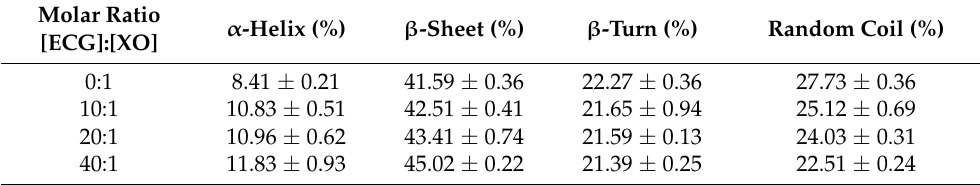
Figure 4. Structural change analysis. ( A ) The CD spectra of XO at different molar ratios of [ECG]:[XO]. c (XO) = 1.0 µ M, and the molar ratios were 0:1, 10:1, 20:1 and 40:1 for Curves 1 → 4, respectively. Fluorescence microscope imaging of XO ( B ) and ECG–XO ( C ). c (XO) = 1.0 µ M; c (ECG) = 40.0 µ M. Table 2. The secondary structure contents of XO in the presence of different molar ratios of